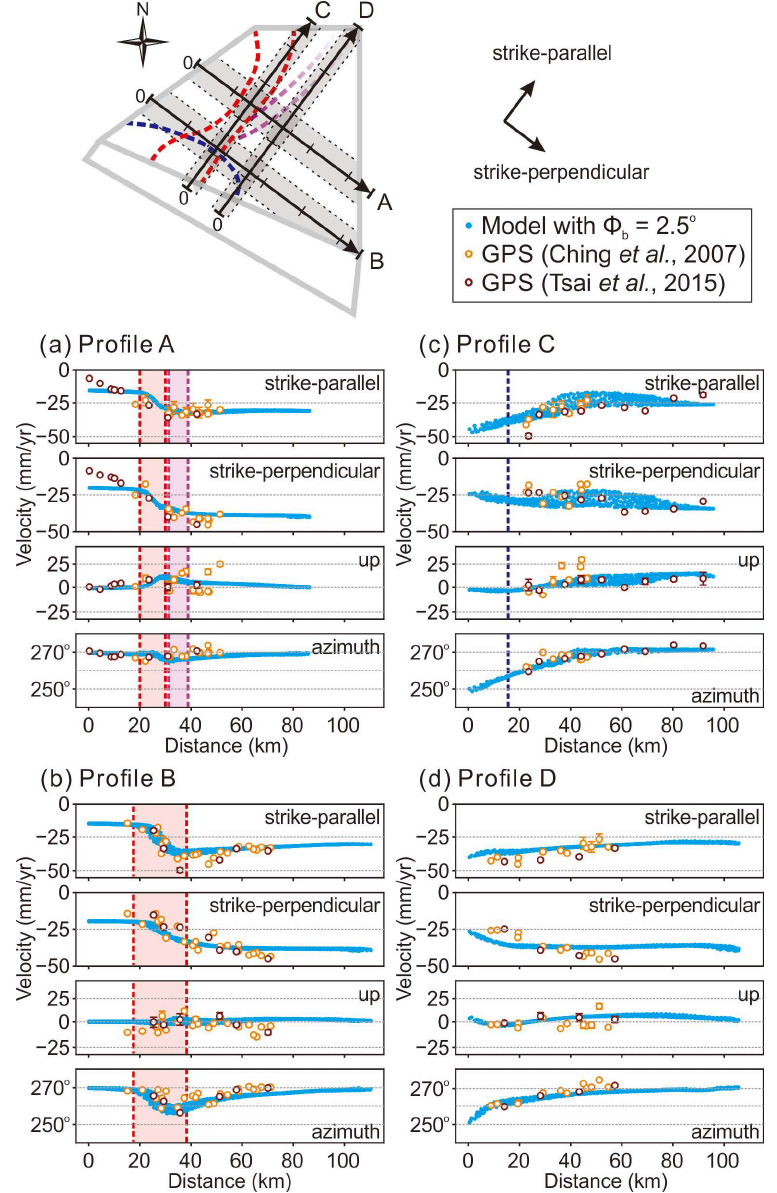
Figure 7. The velocity decomposition of the model and GPS velocity fields [3,4]. The location of the sampling areas and the direction of decomposition are shown in the uppermost part. The distance in the sampling area is marked with ticks every 20 km. The dashed lines are the same structures indicated in Figure 3. ( a – d ) present the velocity decomposition of profiles A, B, C, and D, respectively. The colored bands mark the location of the forethrust (red) and backthrust (purple). In profile A (Figure 7a), we can identify the active shear zones of the forethrust and the backthrust. The forethrust (red zone) is a very active reverse fault with ~17 mm/yr horizontal shortening and 18 mm/yr right-lateral components. The backthrust (purple zone) has no strike-parallel component and only a weak (3 mm/yr) strike-perpendicular component. The region between the forethrust and the backthrust is uplifted with a maximum rate of 13 mm/yr. The GPS data also show a right-lateral thrusting motion across the shear zone, but have a large scattering. Near the western boundary, the model results deviate from the GPS data because our model does not have thrusts there. In the azimuthal profile, the model showed a slight southward rotation between thrusts; its magnitude is small and comparable to the scattering of the GPS data.